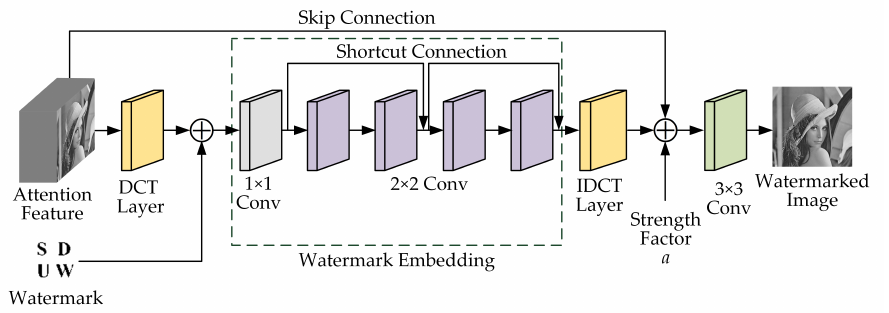
Figure 3. Embedding network: responsible for watermark